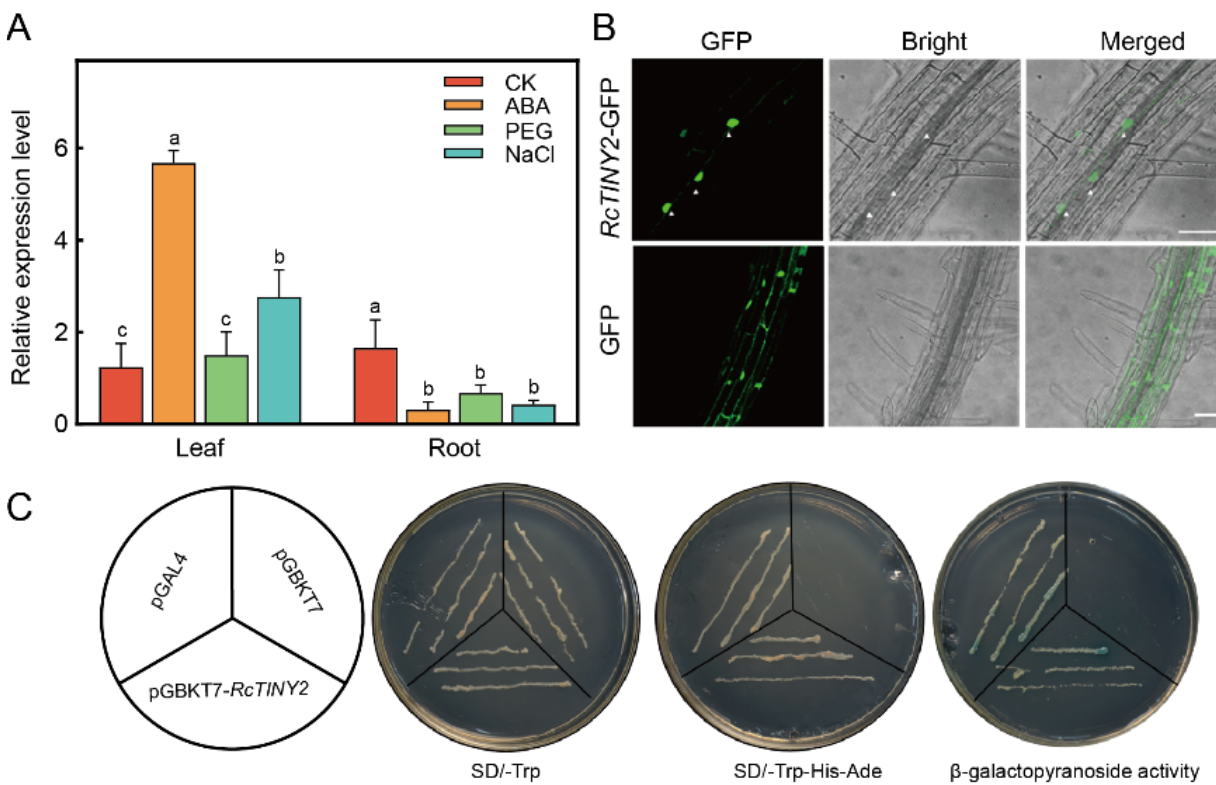
Figure 2. Gene expression, transcriptional activation, and subcellular localization of RcTINY2. ( A ) Level of expression of RcTINY2 in rose leaves and roots under different treatments. The gene RcUBI2 was used to normalize relative expression levels ( n = 3). Statistically significant differences com- pared to the control are indicated by lettered columns (LSD test, p < 0.05); ( B ) In Arabidopsis root cells, RcTINY2 showed nuclear localization. High-resolution laser confocal microscopy set at 488 nm excitation was used to visualize GFP. Bar = 20 μ m. The white triangle indicates the position of the nucleus; ( C ) RcTINY2 transcriptional activation assay using pGBKT7- RcTINY2 -transformed yeast cells. Negative control consisted of cells containing only the pGBKT7 vector. As each panel shows, the α -galactosidase activity assay was performed on yeasts transformed with the noted con- structs and grown on either selective (SD/-Trp/-His/-Ade + X-a-Gal) or nonselective (SD/-Trp) me- dium.